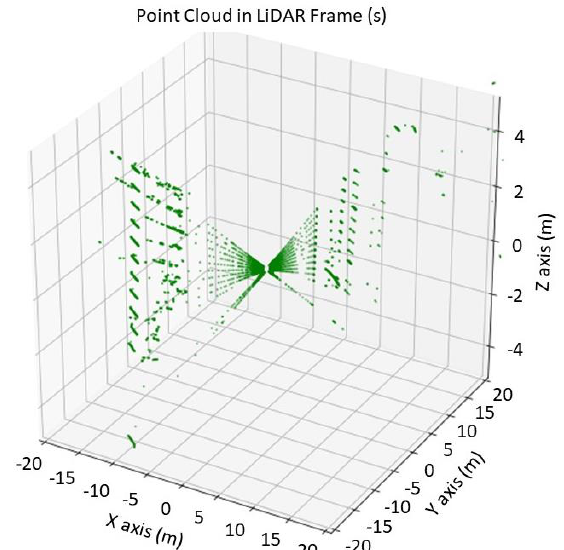
Figure 9 denotes the raw point cloud PC without applying the rotation matrix. This point cloud contains RP and is in the LiDAR reference system.